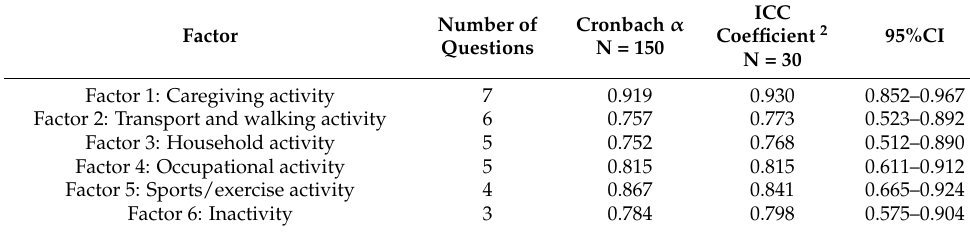
Table 4. Intraclass correlation coefficients and internal consistency of PPAQ-SRB 1 measured by Cronbach’s α